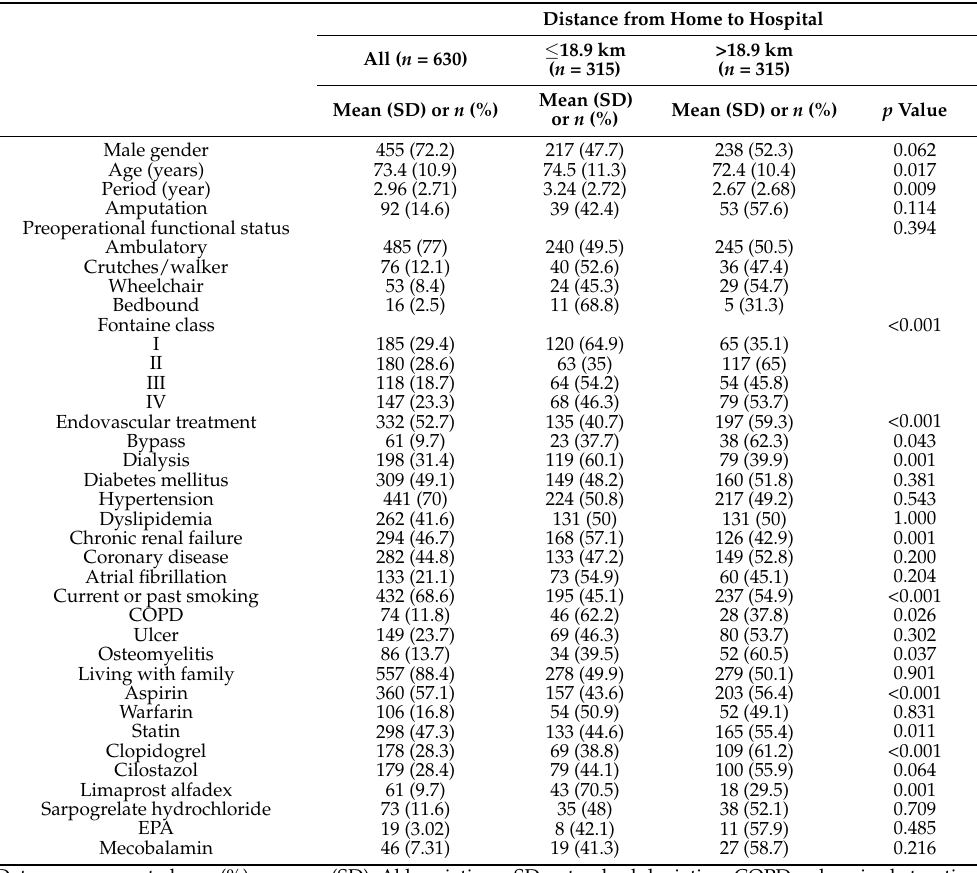
Table 1. Patient characteristics ( n = 630).